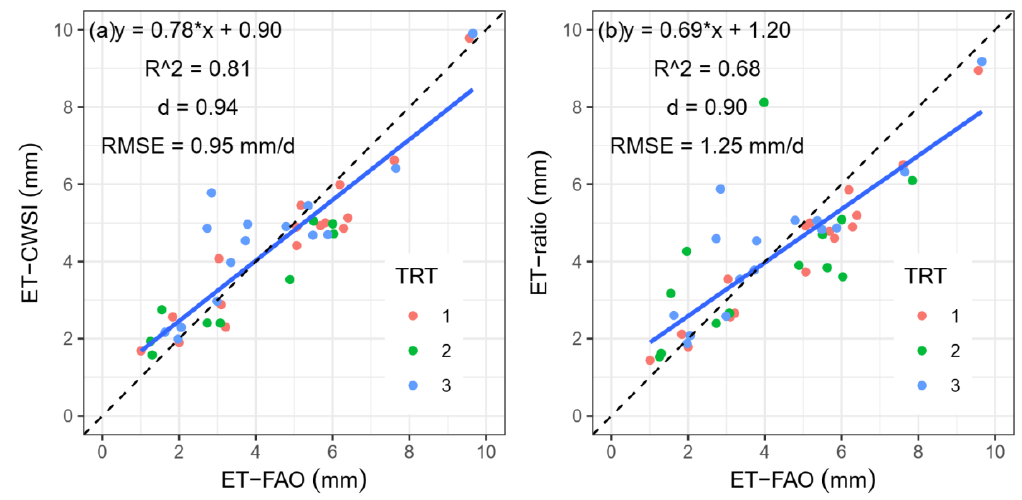
Figure 8. Scatterplots of maize ET obtained by the modified FAO-56 dual crop coefficient method (ET- FAO-56 dual crop coe ffi cient method in three treatments from 6 to 29 August 2017. Methods include FAO) compared with (a) stress coefficient CWSI (ET-CWSI), and (c) T c ratio (ET- T c ratio ) methods in three CWSI ( a ), T c ratio ( b ). Black dotted line is the 1:1 line. The regression relation, coe ffi cient of determination treatments. Black dotted line is the 1:1 line from 6 to 29 August 2017. The regression relation, coefficient of determination (R 2 ), root mean square error (RMSE), and index of agreement (d) are also (R 2 ), root mean square error (RMSE), and index of agreement (d) are also shown.